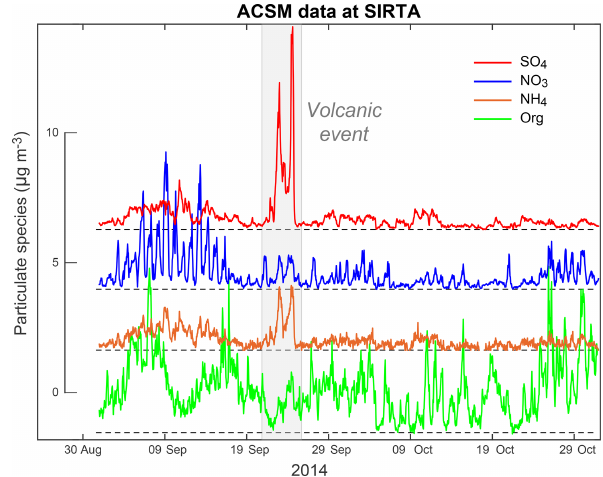
Figure 4. Two-month long time series of the mass concentration of species measured with ACSM (SO 4 in red, NO 3 in blue, NH 4 in orange, Org in green) at SIRTA covering the period September– October 2014 that is punctuated by a major volcanogenic event of air pollution in late